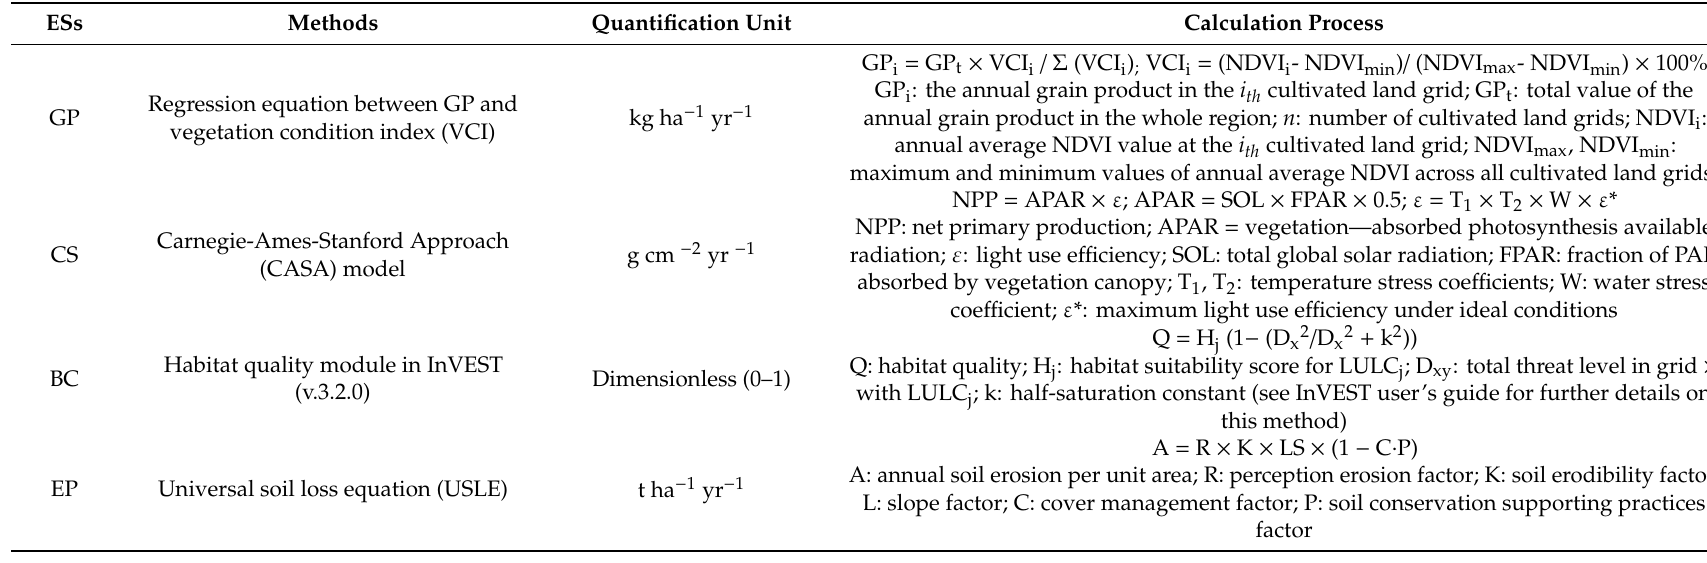
Table A1. Assessment methods or models of four ecosystem